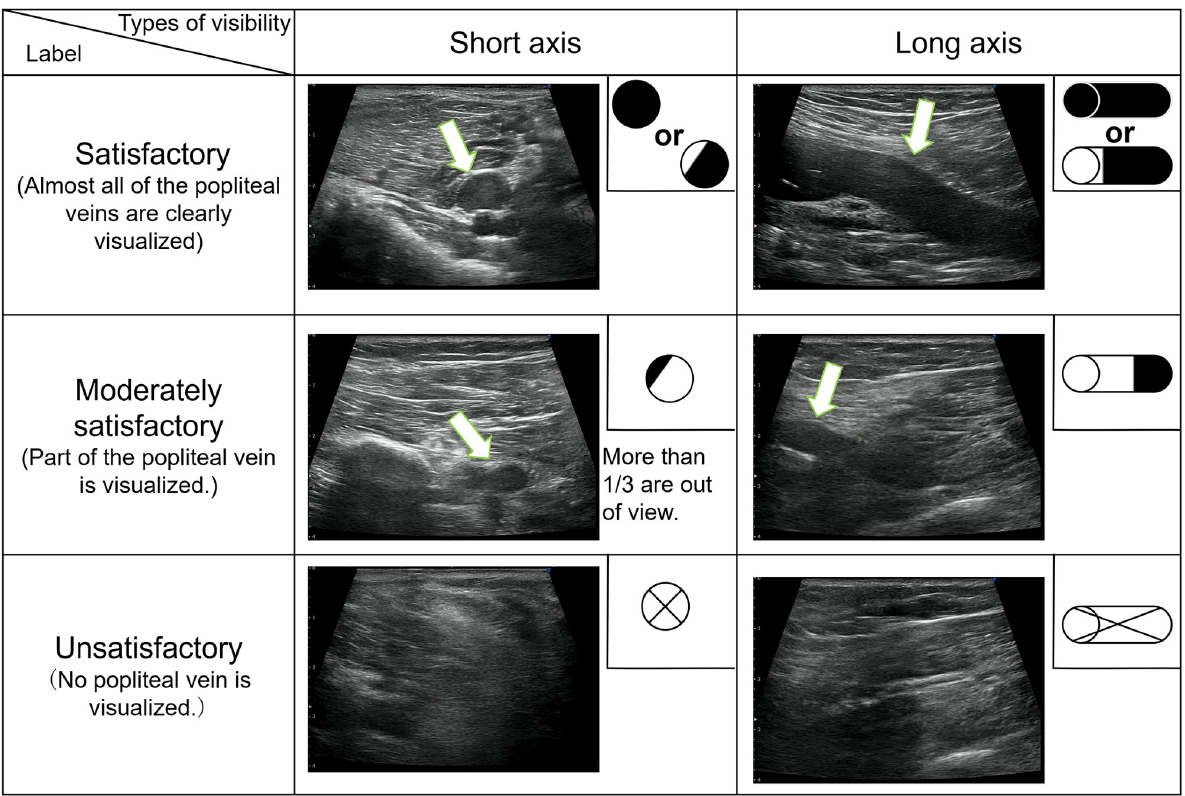
Fig 2. Image classification criteria defined in this study. In a schematic diagram of a blood vessel, black indicates the visualized condition, and white indicates the invisible condition.